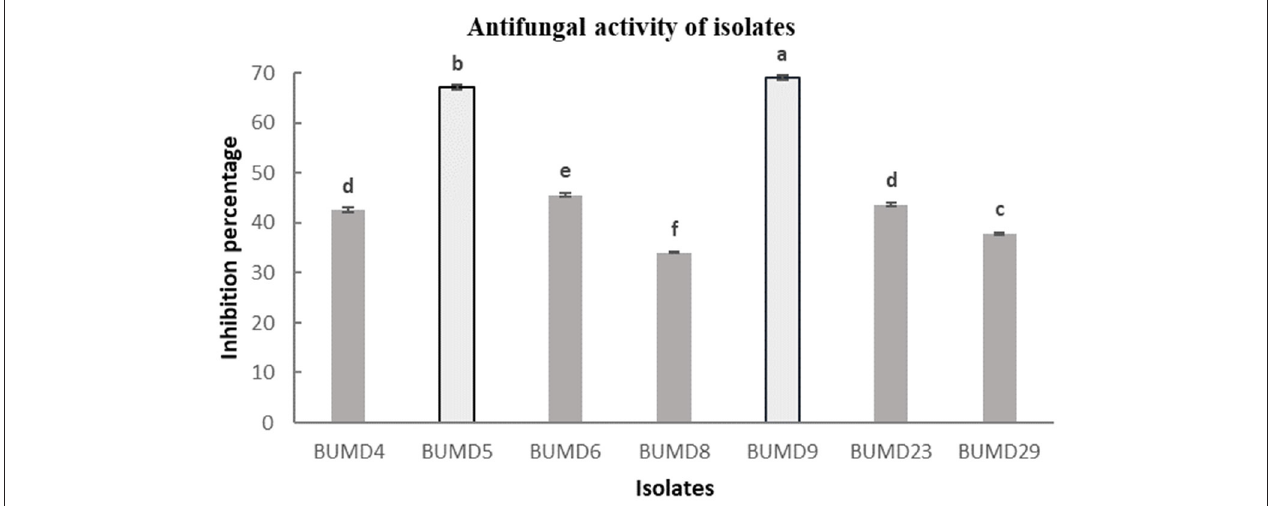
FIGURE 1 | In vitro antifungal activity against Fusarium oxysporum. The strains showing maximum percentage inhibition BUMD5 and BUMD9 were selected for further